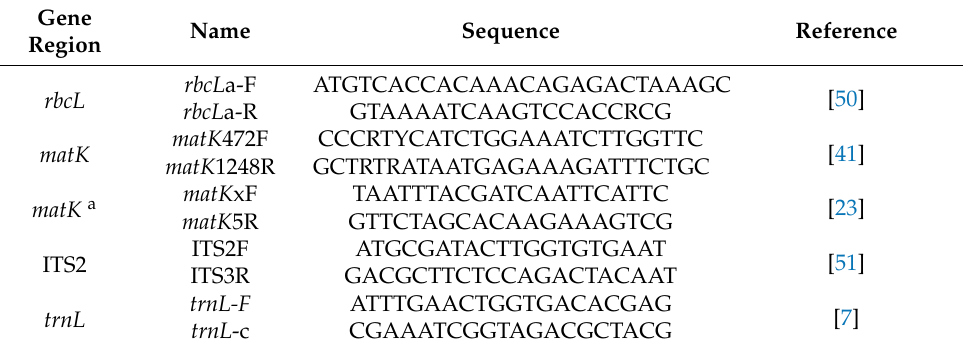
Table 5. Primers used for amplification of DNA regions of ITS2, matK , rbcL , and trnL .